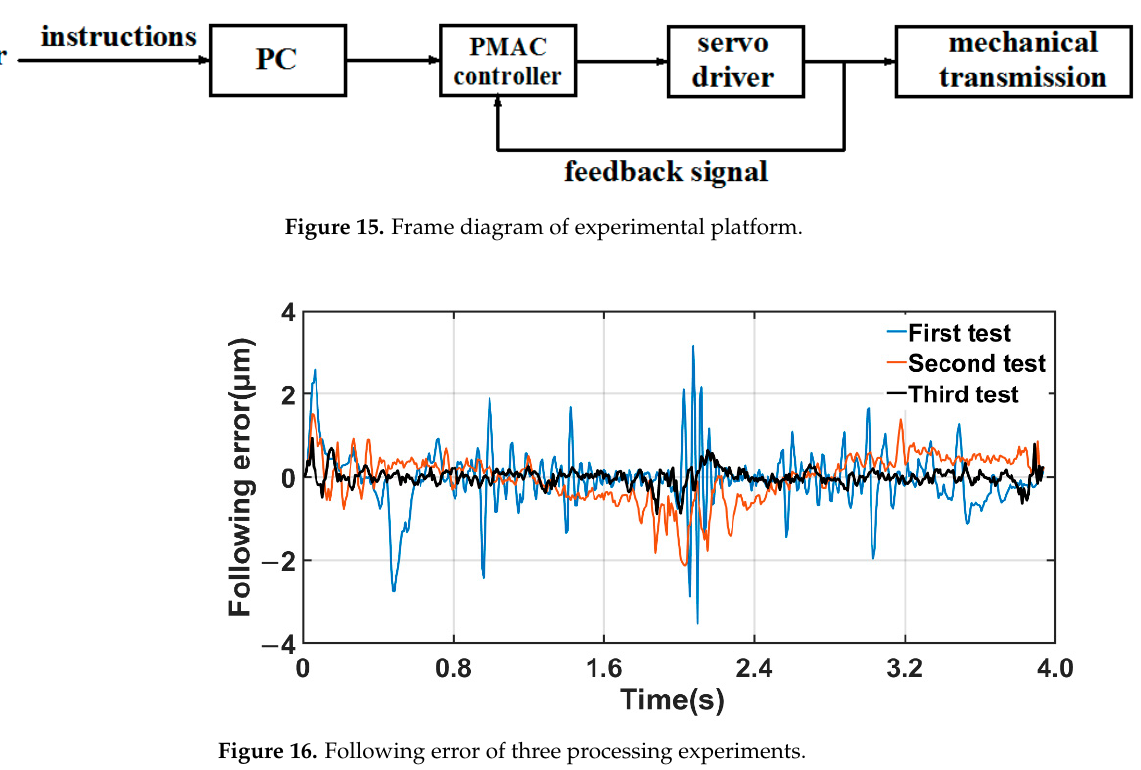
Figure 14. Experiment platform.